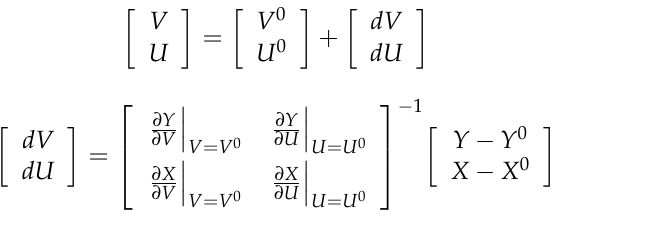
with the ground elevation ( ) h , the horizontal ground coordinates ( are computed using Equation (2). The backward projection is a non-linear equation that